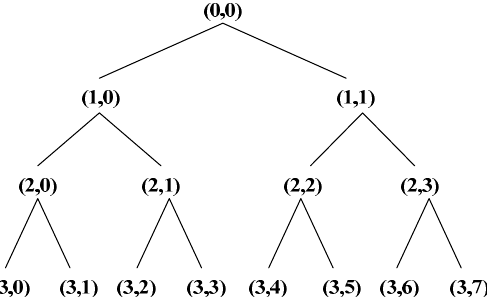
Figure 1. Structure diagram of wavelet packet three-layer decomposition.